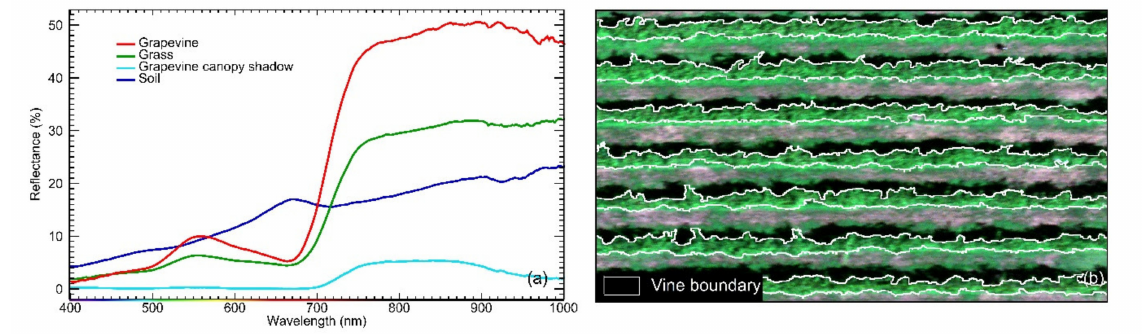
Figure 3. Hyperspectral reflectance spectra of grapevine, grass, grapevine canopy shadow, and soil ( a ). The results of grapevine canopy row delineation (white outlines, b ).